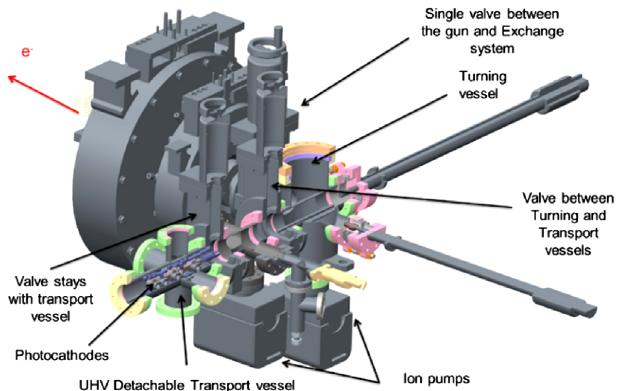
FIG. 15. Schematic of the photocathode